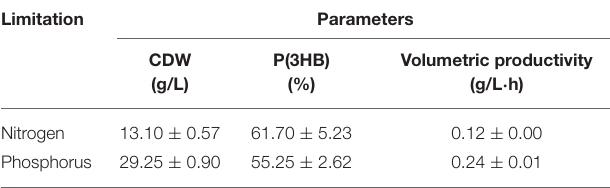
TABLE 3 | Summary of data obtained in fed-batch experiments using Burkholderia sacchari LFM101, supplying xylose as the sole carbon source under different nutrient limitations to PHA accumulation.